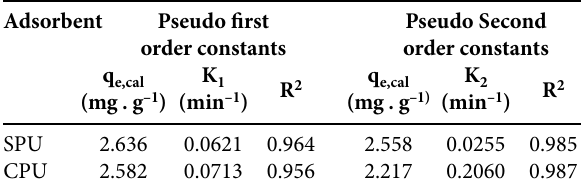
Table 3. Pseudo first order and pseudo second order kinetic con- stant for Pb (II) ion adsorption by SPU and CPU Adsorbent Pseudo first